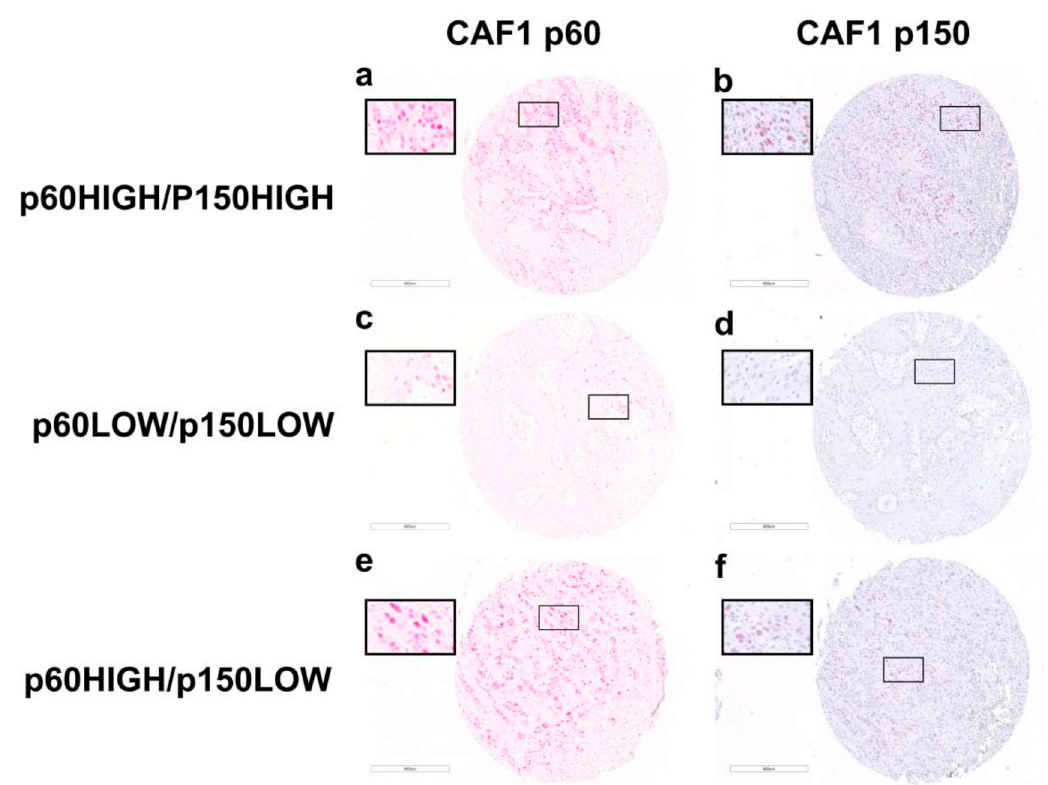
Figure 1. IHC staining of OSCC FFPE tumour samples with anti-CAF-1 p60 and anti-CAF-1 p150 antibodies. The figure shows representative images of anti-CAF-1 p60 and anti-CAF-1 p150 IHC staining intensity in OSCC FFPE tumour samples grouped according to cluster classification as resulted by cluster analysis of immunohistochemistry expression data: ( a , b ) p60 HIGH and p150 HIGH staining category, respectively; ( c , d ) p60 LOW and p150 LOW staining category, respectively; and ( e , f ) p60 HIGH and p150 LOW staining category, respectively. Magnification: for each panel, a 5 × image of the entire core is shown and the inset shows the highlighted region.